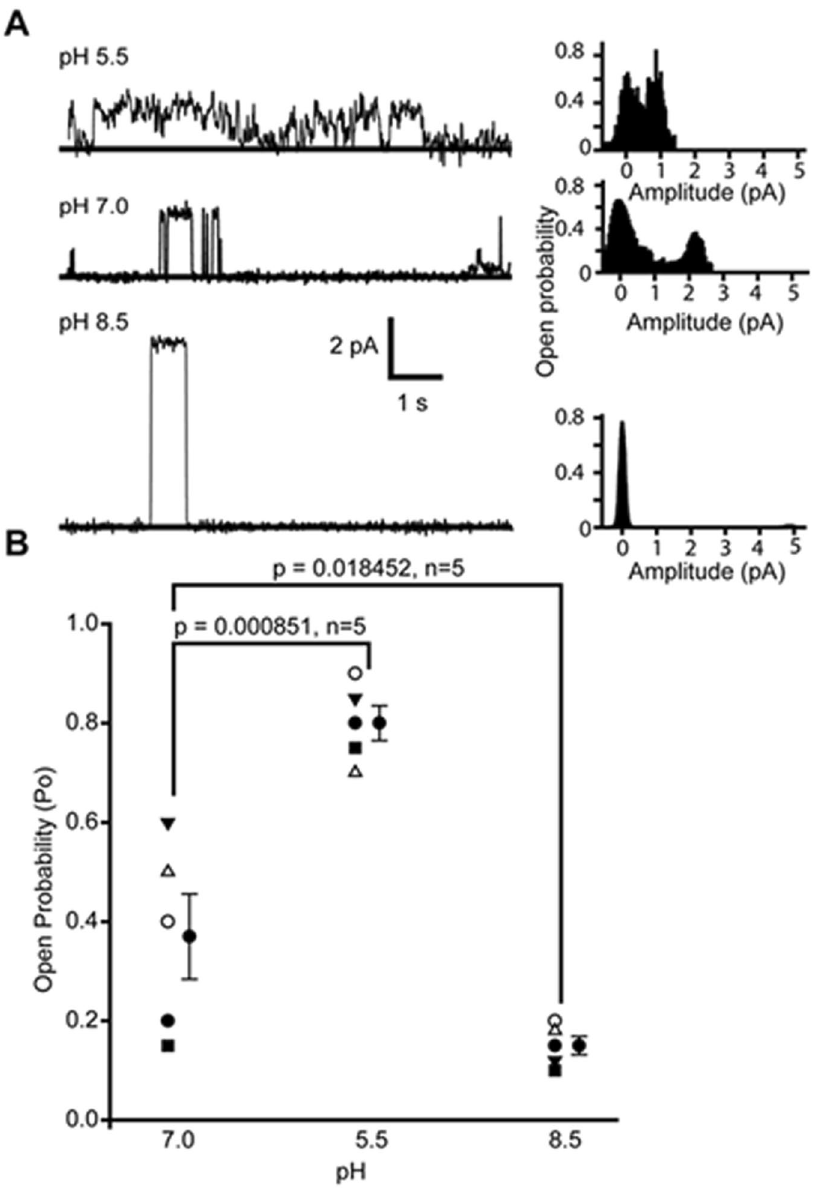
Figure 5. Regulation of SspA by pH. ( A ) Representative traces at pH 5.5, pH 7.0, and pH 8.5 along with their amplitude histograms. The solid line indicates the closed level. ( B ) Open probability of SspA-mediated currents at different pH conditions. The open probability increased significantly (p ≤ 0.001, n = 5) at pH 5.5 as compared to pH 7.0. At pH 8.5 the open probability significantly decreases (p ≤ 0.05, n = 5) as compared to pH